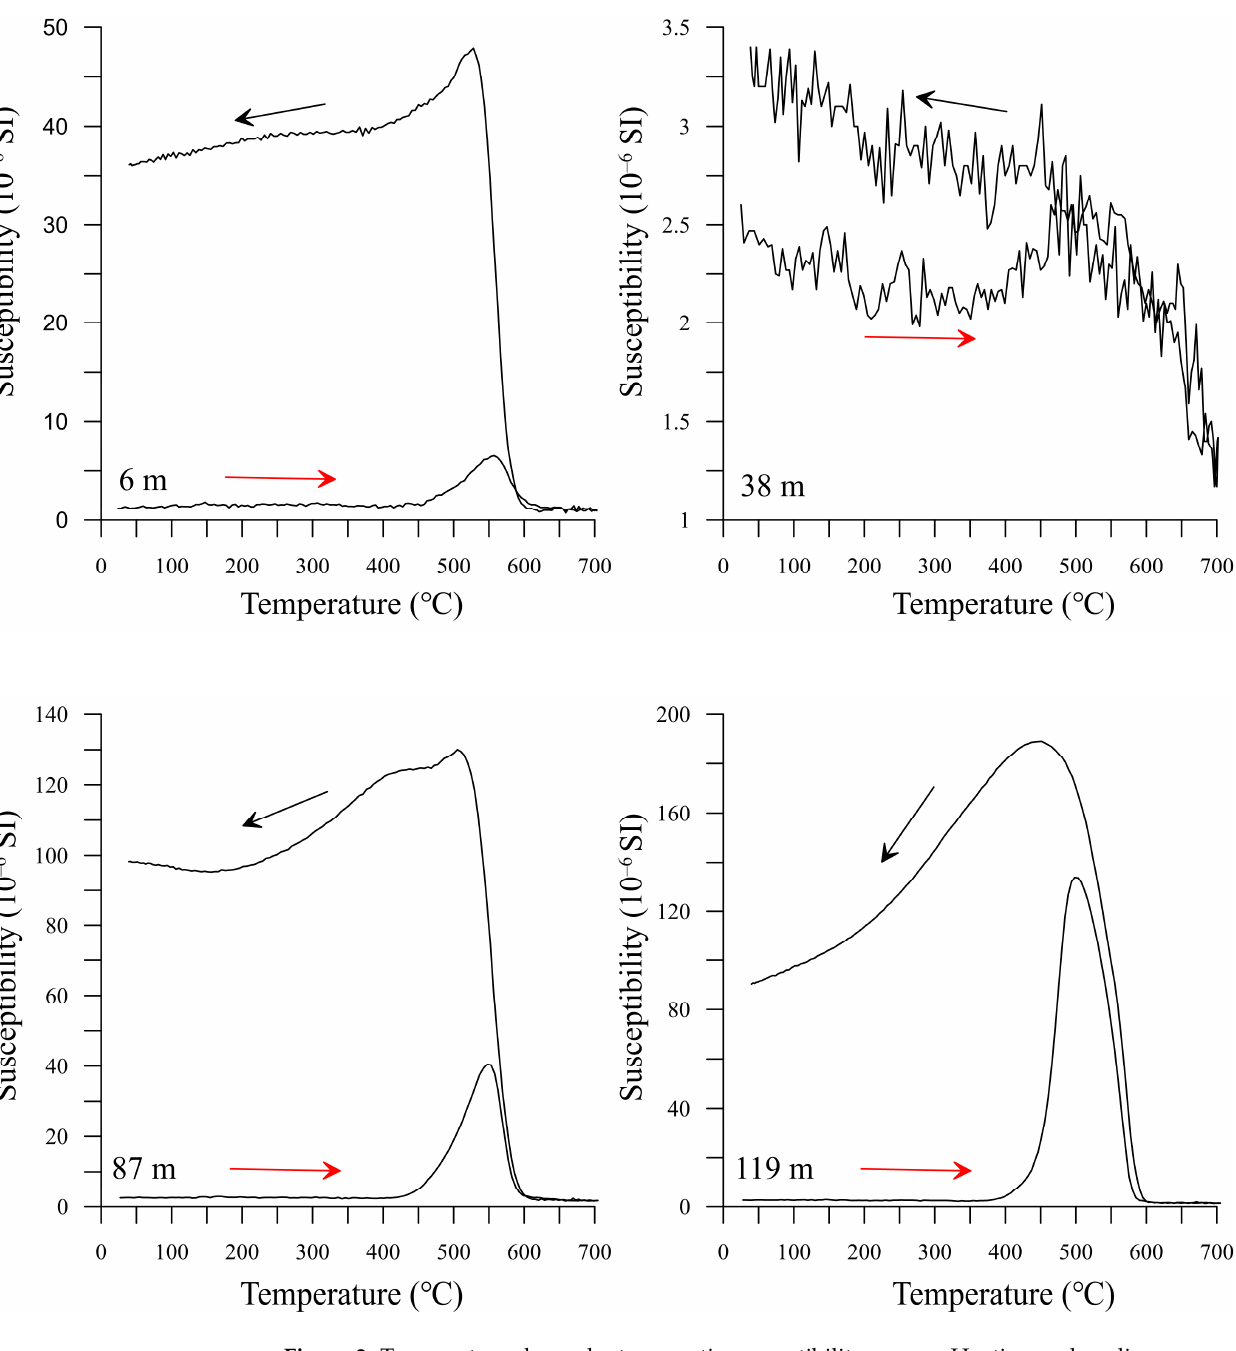
Figure 3. Temperature-dependent magnetic susceptibility curves. Heating and cooling curves are indicated by red and black arrows, respectively.